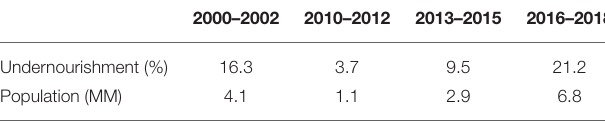
TABLE 1 | Undernourishment (%) and population in